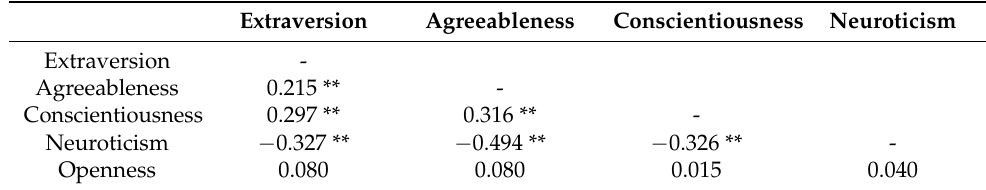
Table 2. Correlation matrix of the Big Five.